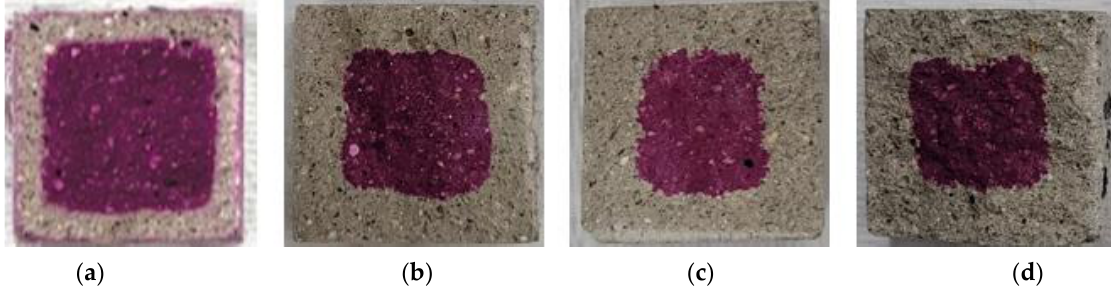
Figure 11. Accelerated carbonation test result of ABFS25: ( a ) 1, ( b ) 2, ( c ) 3, and ( d ) 4 weeks.